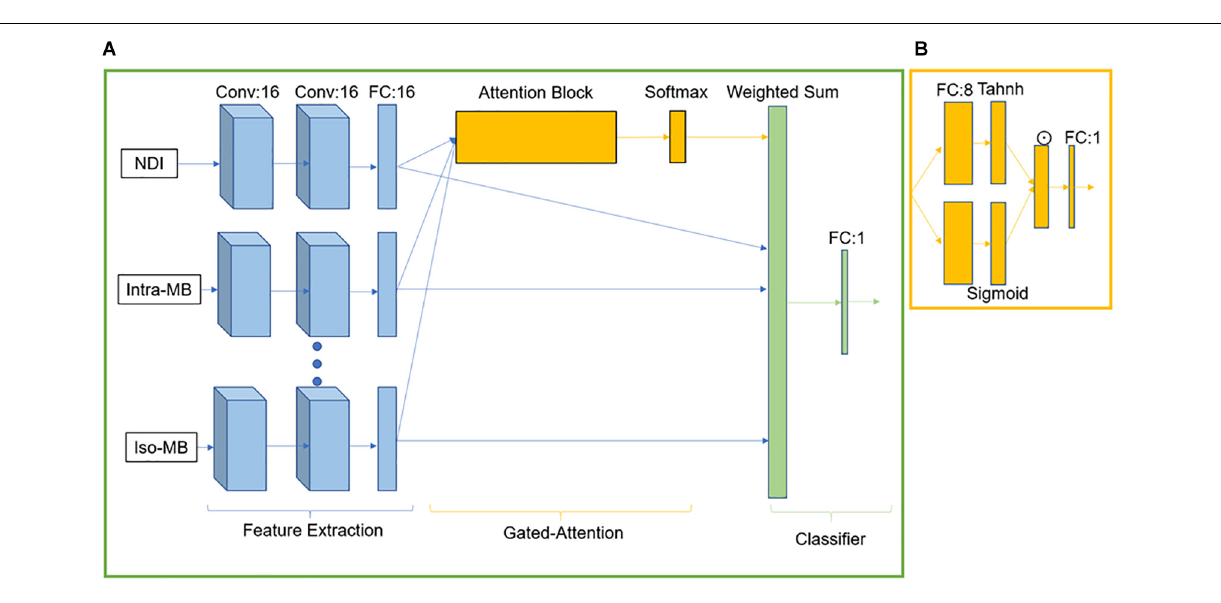
FIGURE 2 | GAMER-MRI. (A) The neural network. Conv stands for the convolutional block. FC is a fully connected layer. (B) Attention block. (cid:12) represents an element-wise